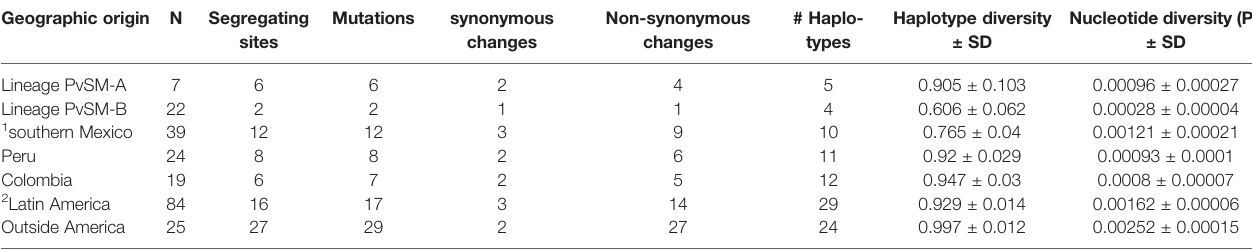
TABLE 2 | Comparison of parameters of genetic diversity of P. vivax ookinete-speci fi c genes between southern Mexican lineages and parasites from other geographical origins. Geographic origin